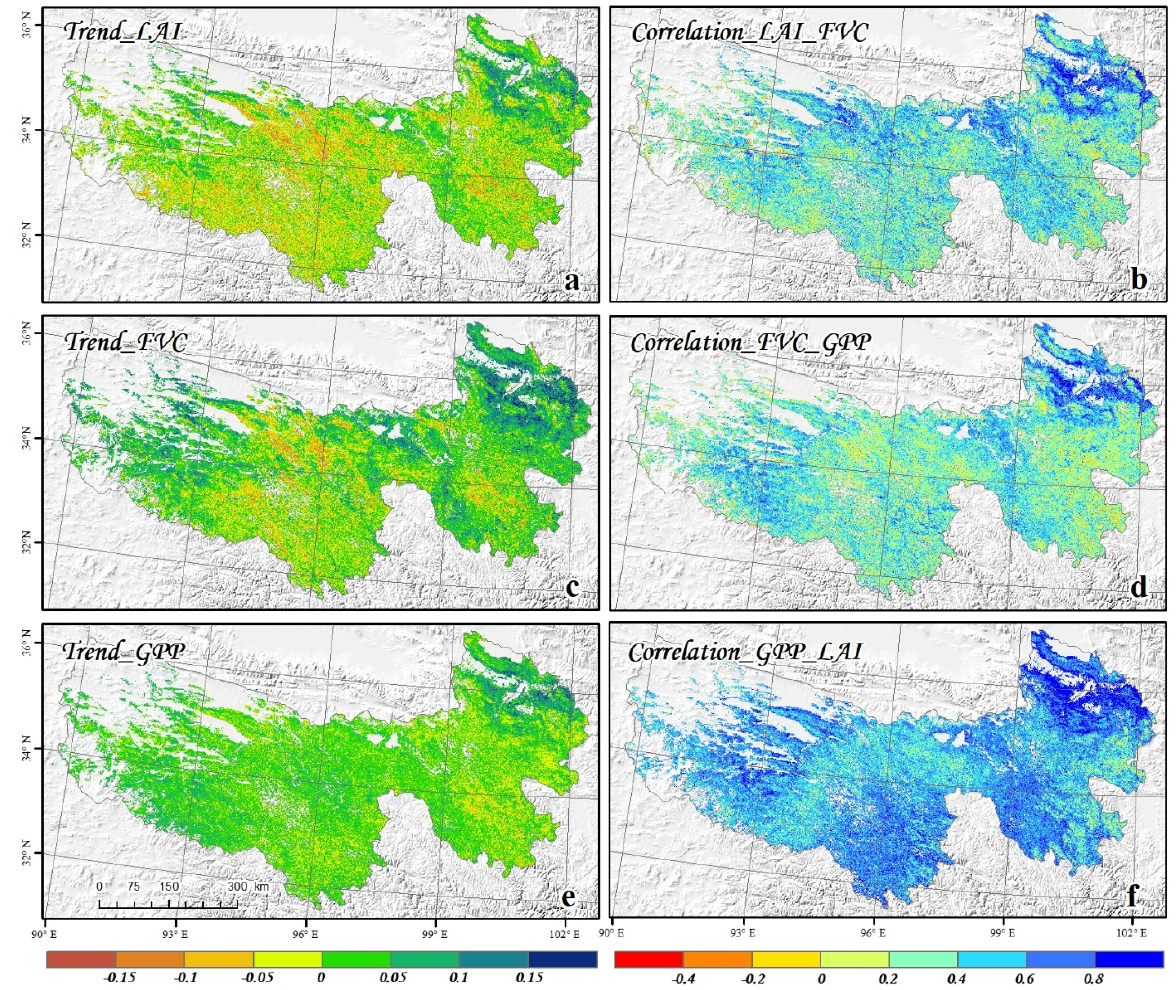
Figure 7. Spatial patterns of the slope values estimated from Theil–Sen trend analysis of LAI ( a ), FVC ( c ), and GPP ( e ), and the r-values estimated from Spearman rank correlation coefficient analysis between LAI_FVC ( b ), FVC_GPP ( d ), and GPP_LAI ( f ) during 2000–2018 across the TRSR. Table 3. Statistical results on the correlations and trends of LAI, FVC, and GPP products during